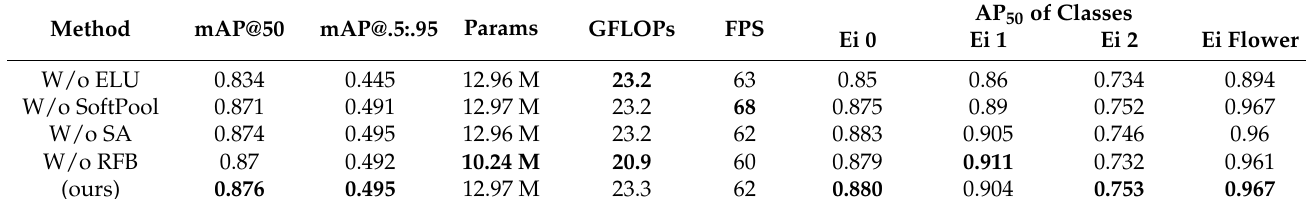
Table 6. Ablation experiment results .